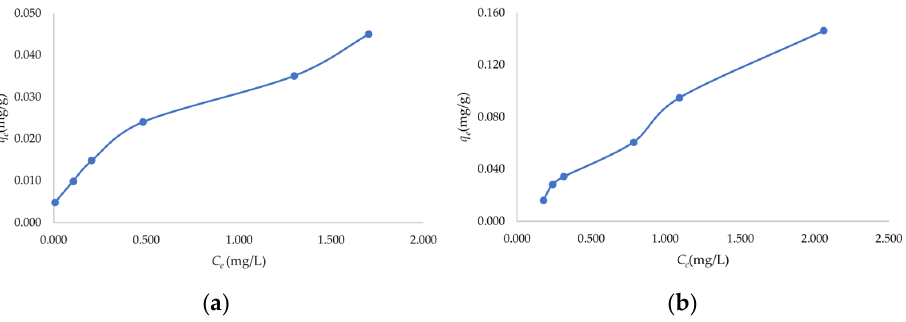
Figure 12. Adsorption isotherms of Fe(III) for adsorbents ( a ) N–PPF adsorbent; ( b ) C–PPF adsorbent. The slope and intercept for the plot of C e versus (cid:3004) (cid:3280) are parameters q m and b , respec- (cid:3044) (cid:3280) tively, where q m (mg/g) is the maximum adsorption capacity of the adsorbent, and b (L/mg) is the Langmuir constant: